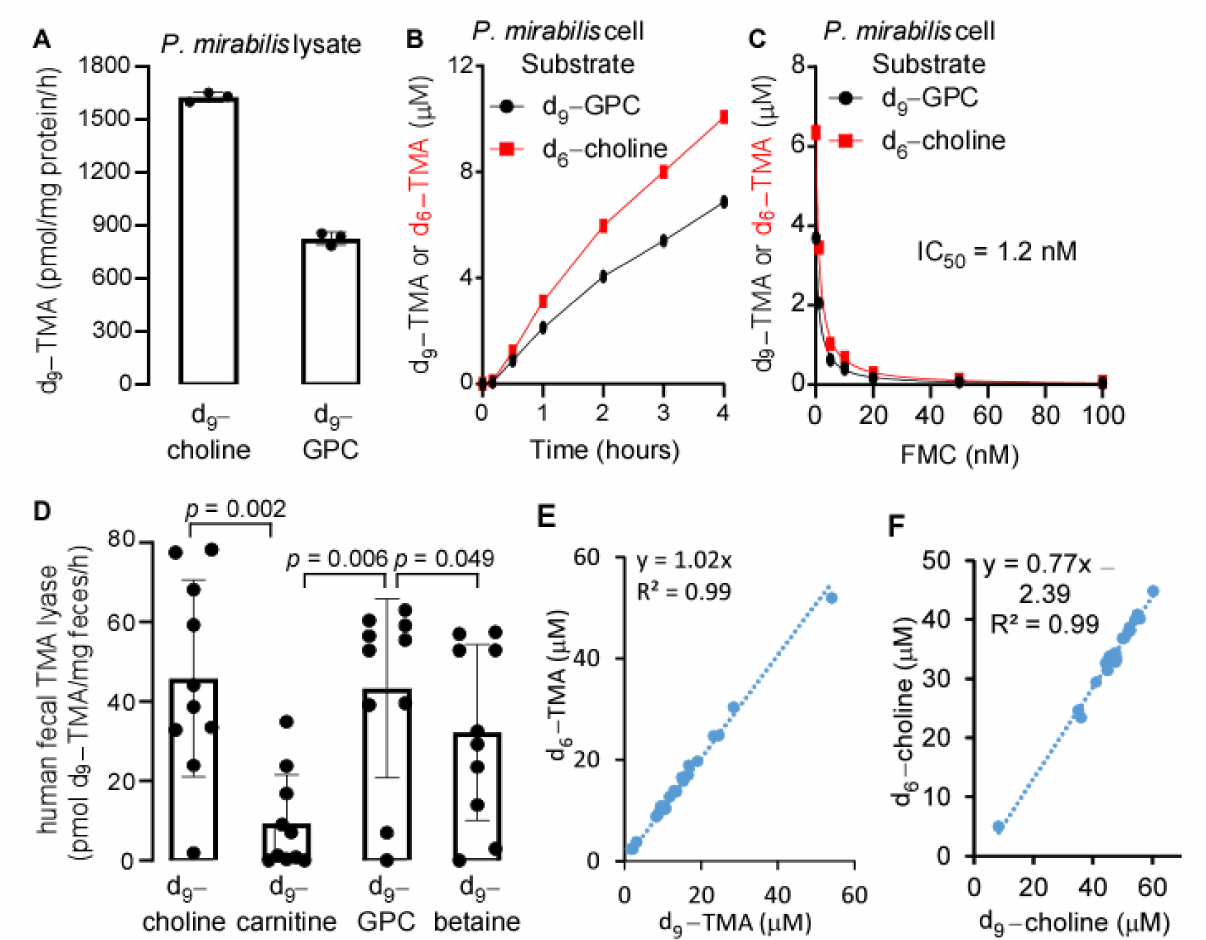
Figure 2. Similarity of GPC to choline as a precursor to produce TMA. ( A ) Proteus mirabilis 29906 lysate catalyzed d 9 -TMA production by utilizing d 9 -choline and d 9 -GPC as substrates. Three milligrams of protein equivalents of lysate were used to incubate with 100 µ M d 9 -choline or d 9 -GPC in 2 mL PBS at 37 ◦ C for 16 h. ( B ) d 9 -TMA and d 6 -TMA produced from d 9 -GPC and d 6 -choline after incubation with P. mirabilis cells at the indicated time, respectively. P. mirabilis was grown in LB medium overnight, and the bacterial cells after centrifugation were resuspended in 1 volume of cold PBS with d 9 -GPC 4 and d 6 -choline added, each at 100 µ M. ( C ) Inhibition of d 9 -TMA and d 6 -TMA production from d 9 -GPC and d 6 -choline, respectively, in the presence of different concentrations of fluoromethylcholine (FMC) for 2 h. Bacterial culture and substrate incubation were conducted as described in panel ( B ). ( D ) Human fecal TMA lyase activity utilizing different substrates. Twenty volumes of 100 µ M different d 9 -labeled substrates were incubated with fecal tissue for 16 h to quantify d 9 -TMA production by LC-MS. Fecal TMA lyase activity is expressed as pmol d 9 -TMA/mg feces/h. Comparison between substrates was conducted by Wilcoxon matched-pairs signed rank test, where p < 0.05 is considered significant. ( E ) Correlation of d 6 -TMA to d 9 -TMA after mouse cecal contents were incubated with 100 µ M d 9 -GPC and 100 µ M d 6 -choline at the same time for 16 h under anaerobic conditions, n = 23. ( F ) Correlation of d 6 -choline to d 9 -choline after cecal contents were incubated with d 6 -choline and d 9 -GPC, as described in panel E . d 9 -TMA and d 6 -TMA were quantified by LC-MS/MS, as described in Materials and Methods, and d 6 -choline and d 9 -choline were quantified by LC-MS/MS after being filtered through a 3K-cut off filter with d 4 -choline added as internal standard. Data are presented as mean ± SD from three replicates in panel ( A ), two replicates in panels ( B , C ), and ten replicates in panel ( D ), with scatter plots in panels ( A , D